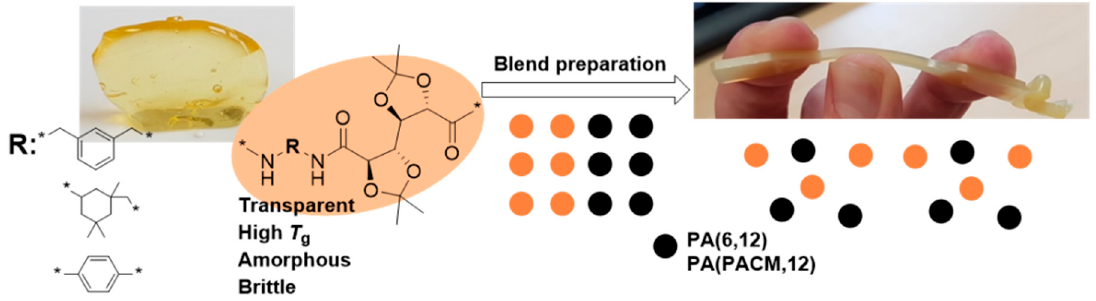
Figure 1. Approach for the preparation of blends from biobased GalX polyamides (PAs). PA(6,12) – polyamide composed of 1,6-diaminohexane and 1,12-dodecanedioic acid, PA(PACM,12) composed of 4,4 ′ -methylenebis(cyclohexylamine) and 1,12-dodecanedioic acid.